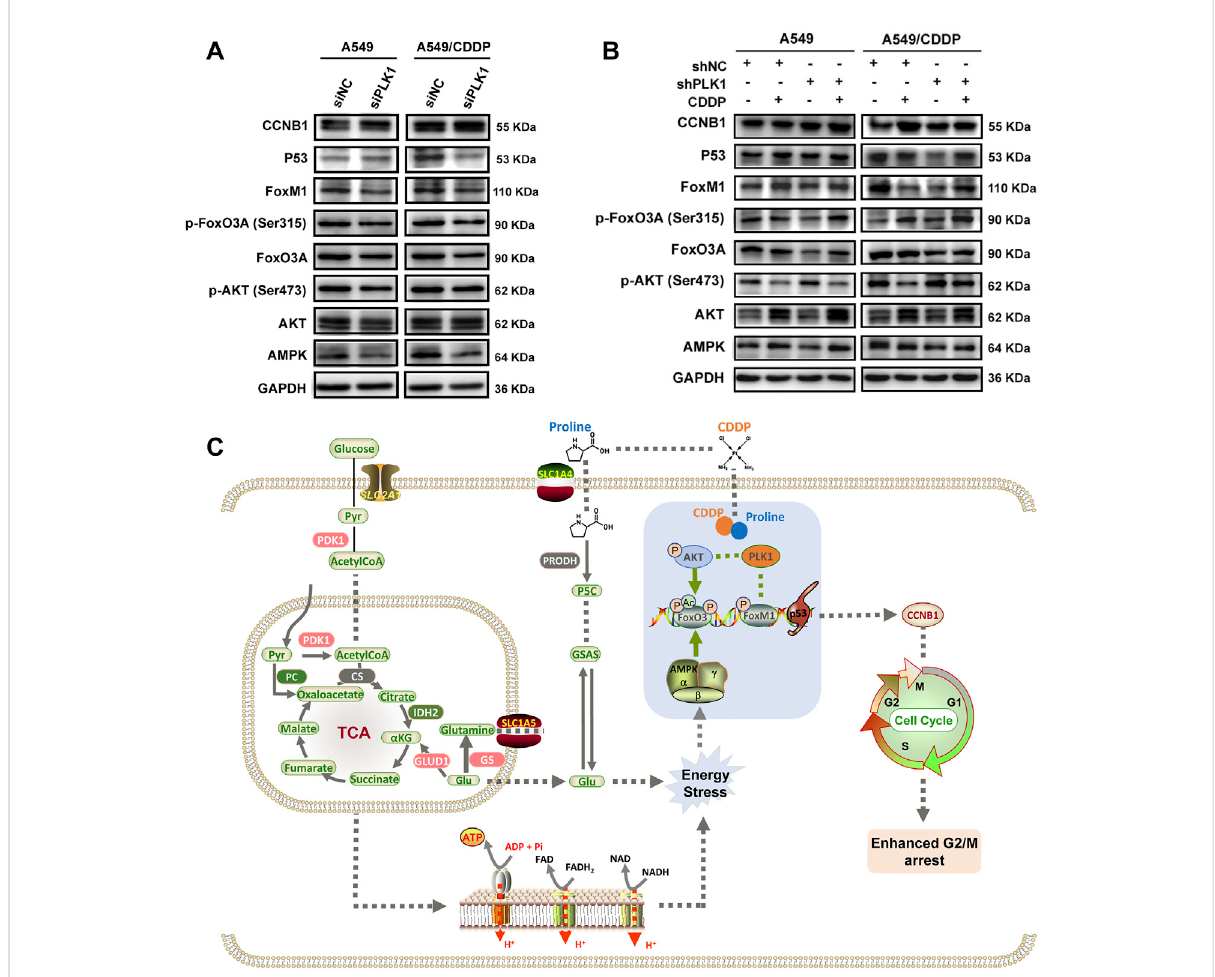
FIGURE 6 TheexpressionlevelsofmarkersinvolvedincellcyclearrestinducedbyPLK1inhibition. (A) ThelevelsofAMPK,AKT,p-AKT,FoxO3A,p-FoxO3A, FoxM1, P53, and CCNB1 in the parental and cisplatin-resistant A549 cells infected with PLK1 siRNA. (B) The shNC- or shPLK1-transfected A549 and A549/CDDP cells were incubated with 5 μ M CDDP to detect the expression levels of PLK1-related proteins. (C) Working model showing the underlying mechanism of proline enhanced cisplatin sensitivity in NSCLC